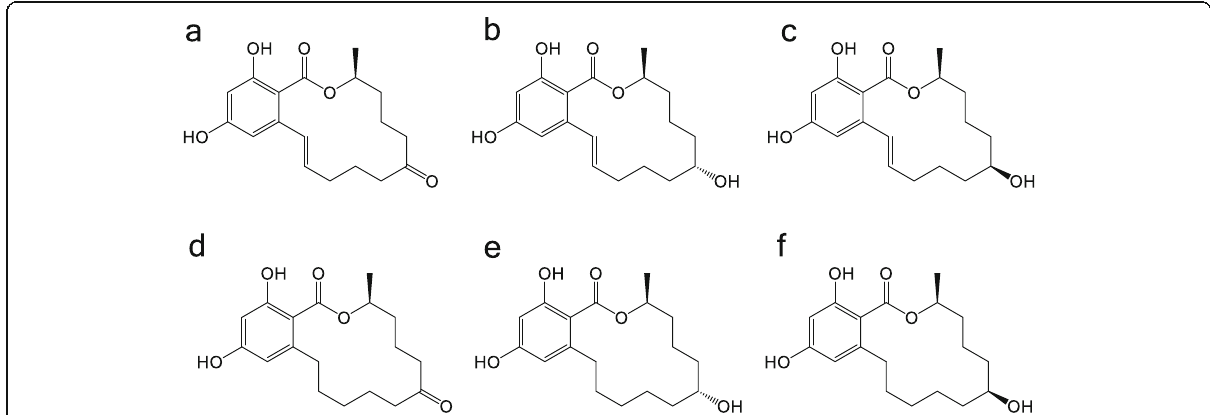
Fig. 2 Chemical structures of ZEN and its derivatives: ( a ) zearalenone, ( b ) α -zearalenol, ( c ) β -zearalenol, ( d ) zearalanone, ( e ) α -zearalanol, and ( f ) β - zearalanol (Marin et al.,